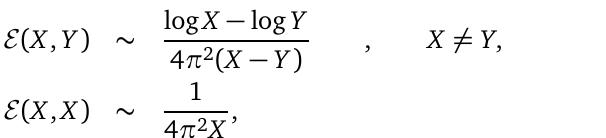
Figure 8: Rescaled distribution of the rightmost particle (rightmost up spin). As be- − t sin γ (cid:112) fore the abscissa is X = x , and data is shown for ∆ = 1 / 2 (left) and ∆ = 1 / t cos γ (right). In both cases the collapse is good, and shows that the rightmost particle is = t sin γ for the times we could access, even mostly concentrated on the left of x e = t . The rescaled density profile for though its long right tail goes all the way to x free t = 240 is also shown in orange solid line for comparison (it is appropriately normal- ized to allow for comparison with the distribution). To help visualize the location of both edges (red x and blue x bullets), the same distribution is shown in the inset e f as a function of x / t